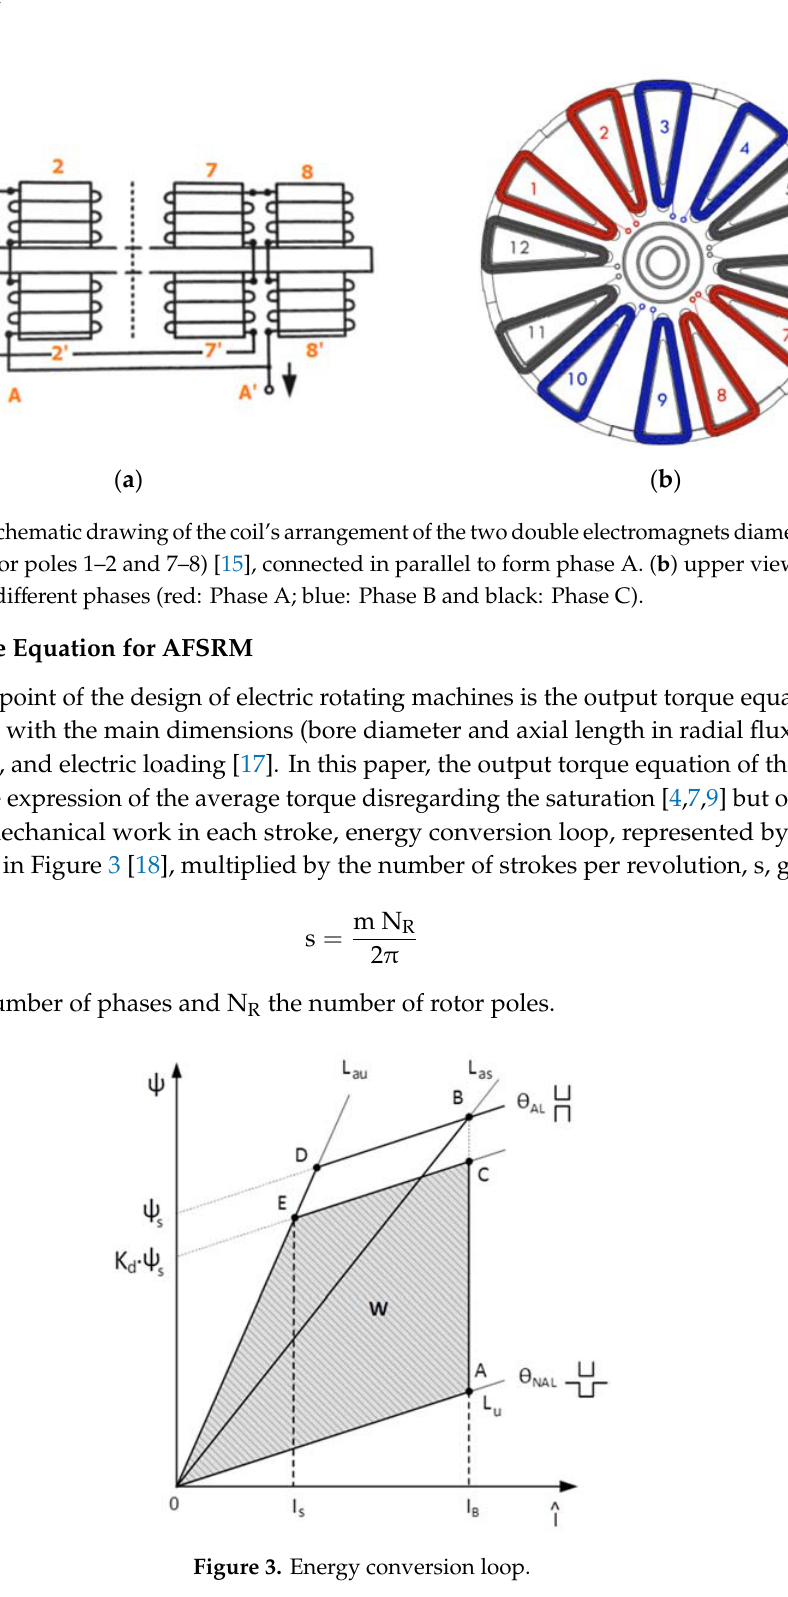
Figure 3. Energy conversion loop.